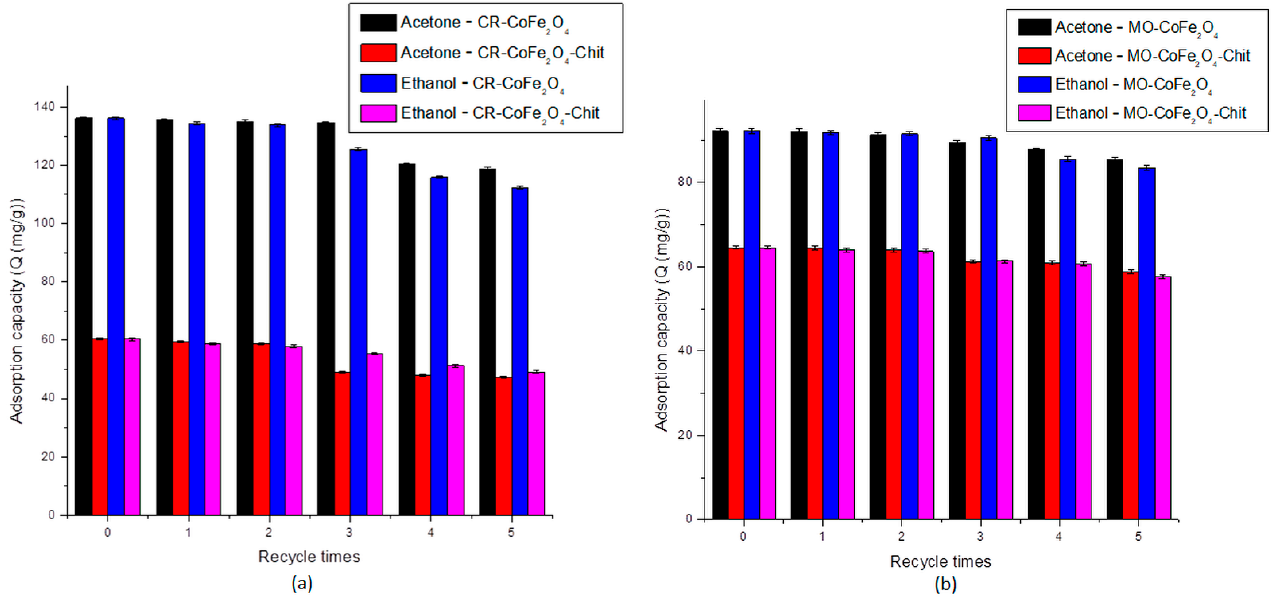
Figure 17. Reusability of CoFe 2 O 4 and CoFe 2 O 4 − Chit for CR ( a ) and MO ( b ).